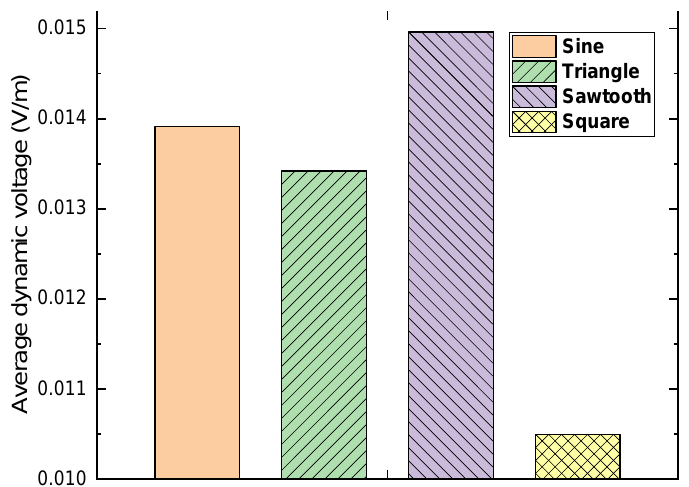
Figure 11. Average dynamic of a 4 mm HTS tape, carrying a 30 A DC transport current and in the presence of four different perpendicular AC magnetic fields (sinusoidal, triangle, sawtooth and square) at 50 Hz, with the peak magnitude 90 mT.